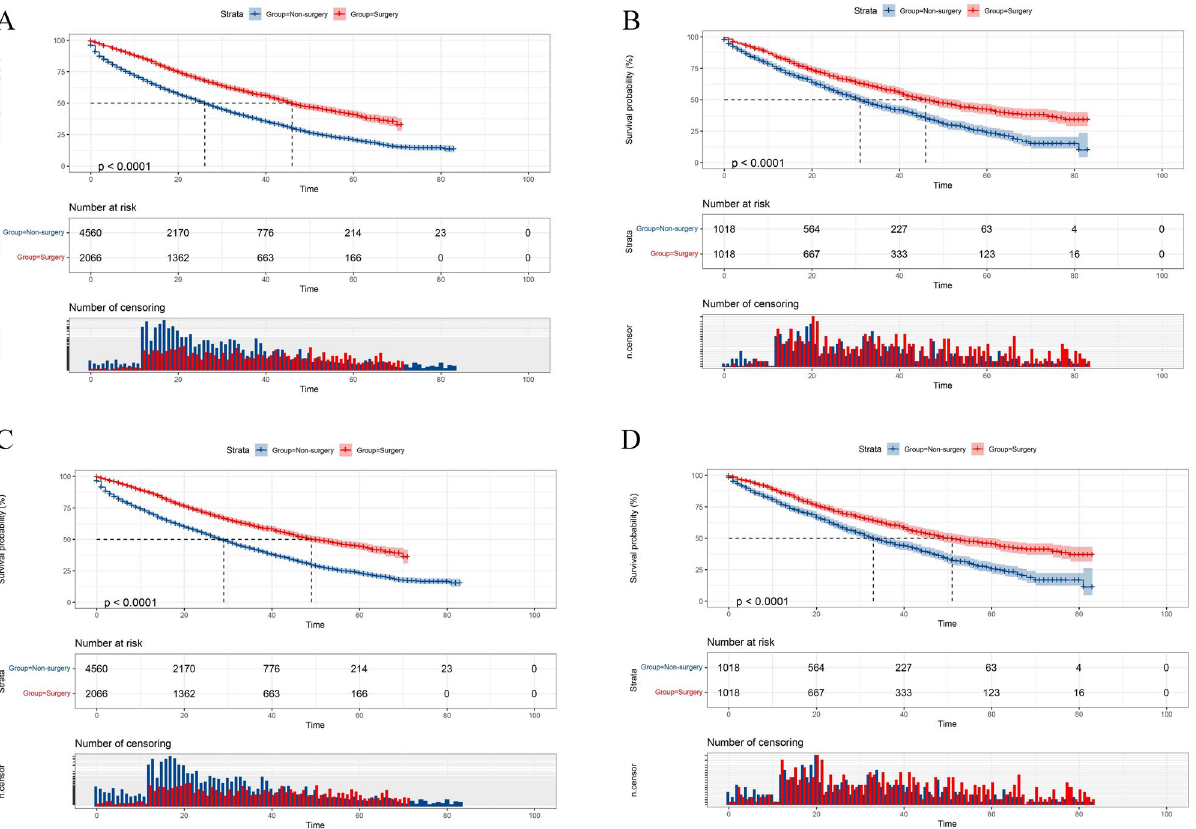
Figure 2. Kaplan–Meier survival analysis of OS in the surgery and non-surgery group before PSM ( A ) and after PSM ( B ), and CSS in the surgery and non-surgery group before PSM ( C ) and after PSM ( D